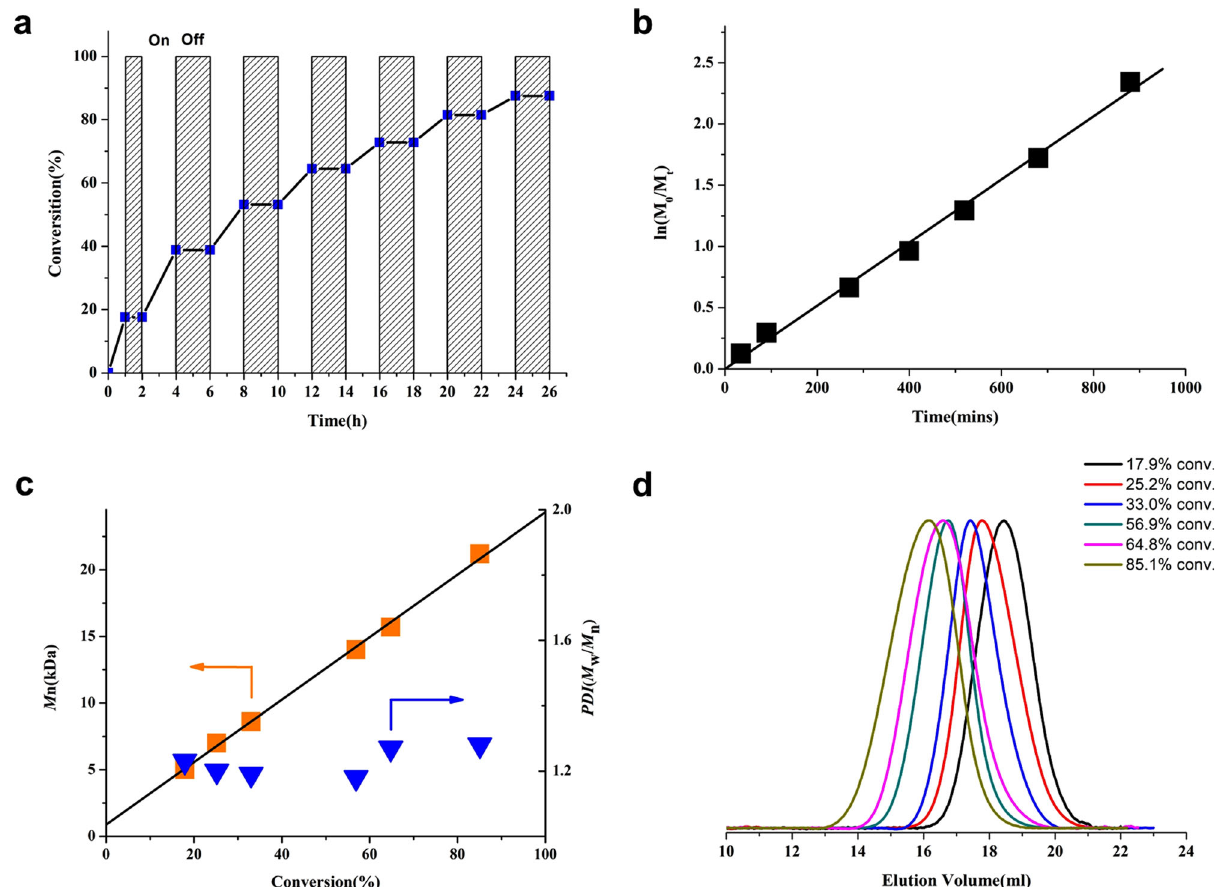
Fig. 3 Temporal control and kinetic study on ODA 5d-catalyzed ATRP of MMA. a Light on – off experiments and the plot of monomer conversion vs time. b Kinetic plot for the metal-free ATRP. c Plot of M n and Đ vs monomer conversion for the polymerization of MMA under continuous irradiation. d GPC traces of each polymer depicted in ( c ) (color coded). All polymerizations were performed at a ratio of [MMA] 0 :[DBMM] 0 :[ 5d ] 0 = 200:1:0.05 under purple LED irradiation (400 nm, 25 mW cm – 2 )